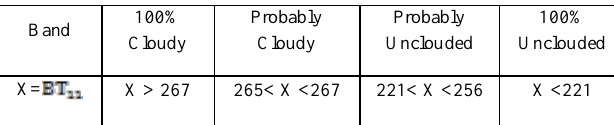
Table 3: calculated threshold for (April 20 th )